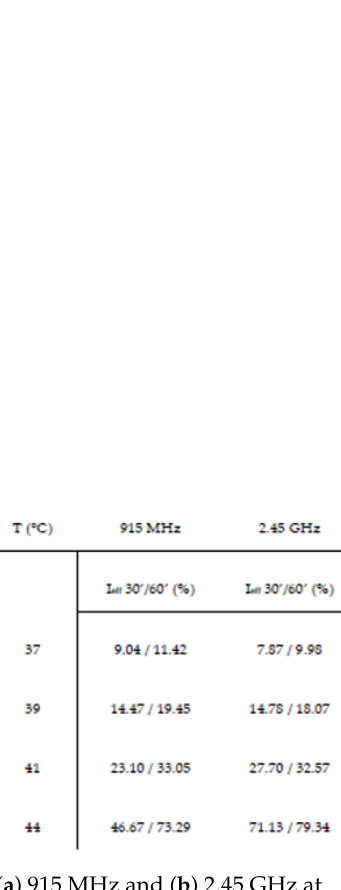
Figure 13. Arrhenius plot for heat inactivation efficiency (I eff ) of B16 melanoma cells at ( a ) 915 MHz and ( b ) 2.45 GHz at time points 30 min (30 (cid:48) , blue dashed line) and 60 min (60 (cid:48) , black dashed line) in the temperature range between 37 ◦ C and 44 ◦ C. Accompanying inactivation efficiency was calculated by linear regression showing I eff at different